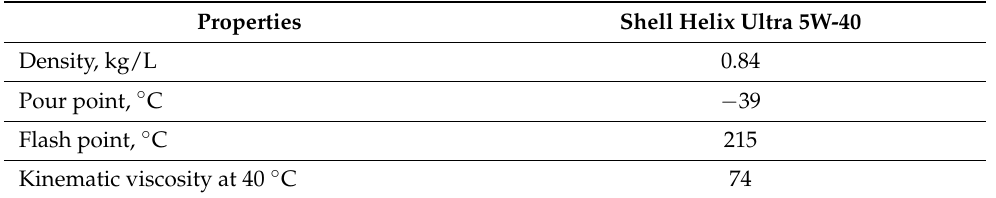
Table 4. The main characteristics of motor